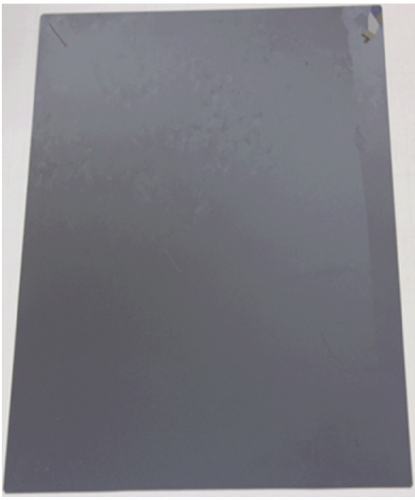
Figure 3: The appearance of quasi-mono silicon after texturing.